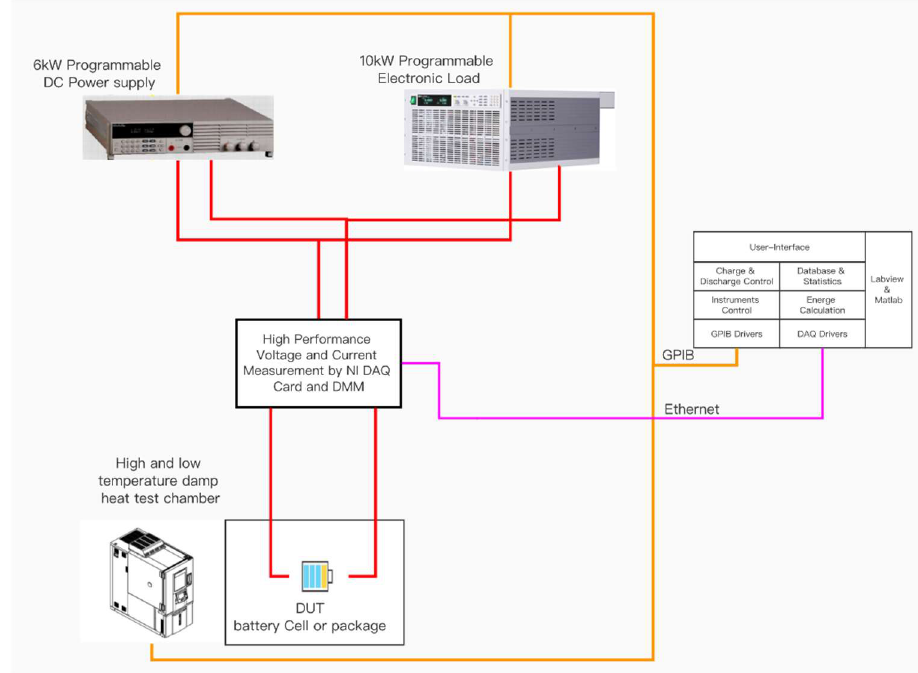
Figure 3. Architecture diagram of battery characteristic test platform.